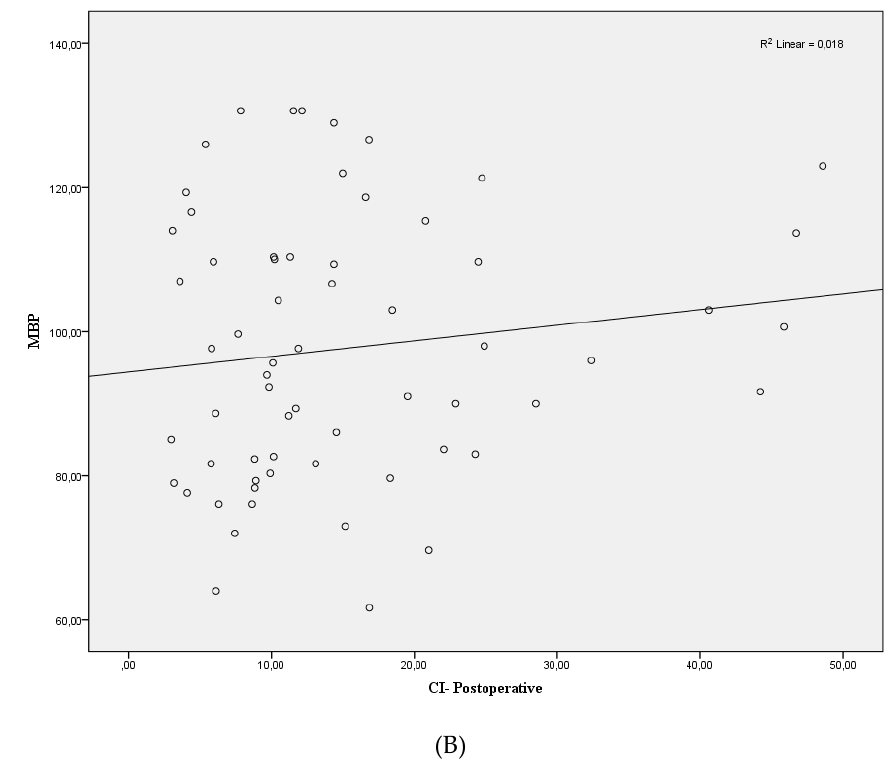
Figure 3. Scatter plots showing the relationships of preoperative ( A ) and postoperative ( B ). Mean blood pressure (MBP) and collapsibility index (CI) of inferior vena cava. p > 0.05.